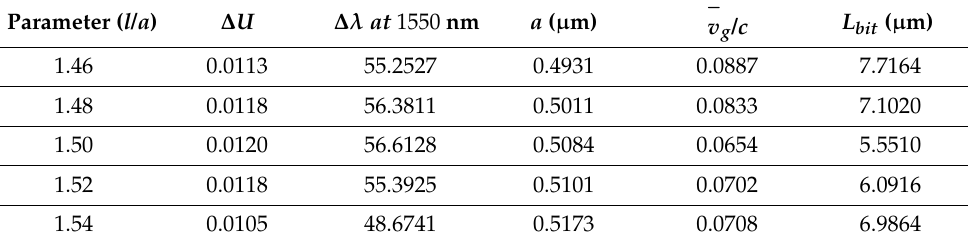
Table 1. EPCW optical buffering properties at different values of triangle-defect side length l . Parameter ( l / a ) ∆ U ∆ λ at 1550